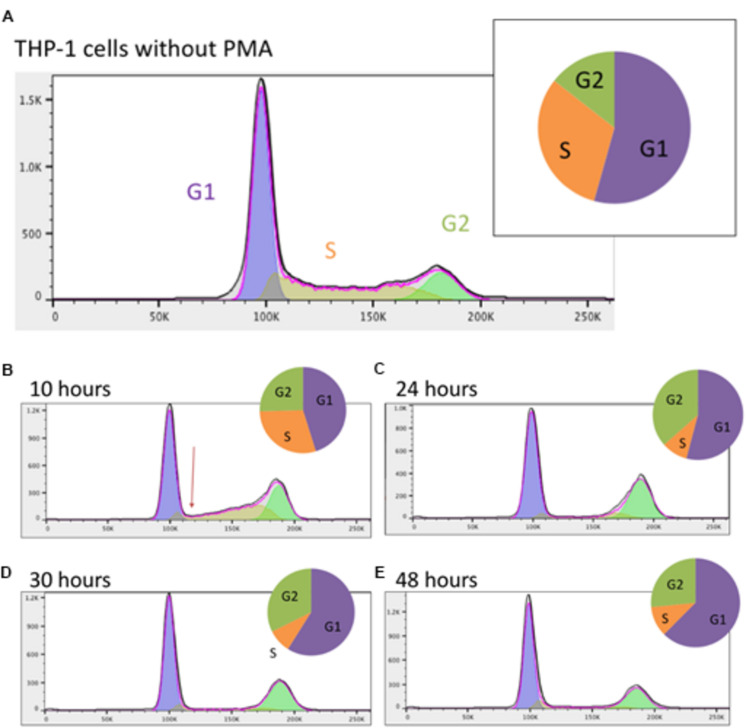
Analysis of the cell cycle in THP-1 cells. (A) Prior to PMA stimulation; (B) 10 h post PMA stimulation; (C) 24 h post PMA stimulation; (D) 30 h post PMA stimulation; (E) 48 h post PMA stimulation. Data were analyzed using FlowJo with the Watson (pragmatic) model. Line graph shows the number of cells in each phase, taken from FlowJo software; X axis shows the propidium iodide fluorescence and Y axis shows cell count. Arrow in (B) highlights the immediate rapid decline in S phase entry in response to PMA. Pie chart shows the proportion of cells in each phase. Purple – G1 phase; orange – S phase; green – G2 phase.